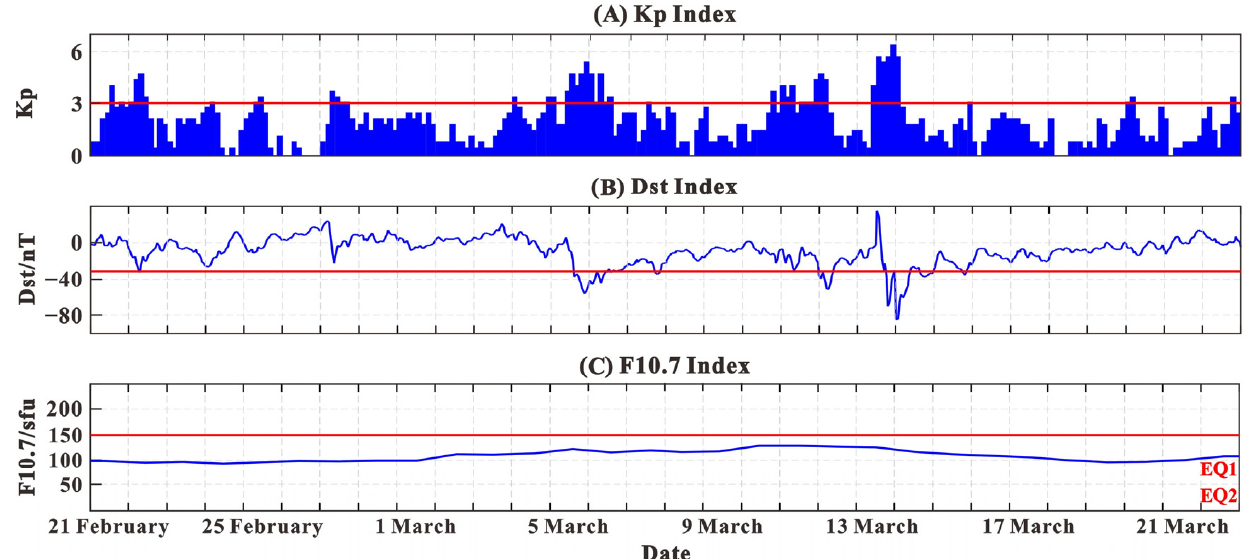
Figure 2. Space weather from 21 February to 22 March 2022, where ( A – C ) denote Kp , Dst , and F 10.7 indices, respectively. The red lines represent the thresholds used to judge whether the space weather is quiet or not.